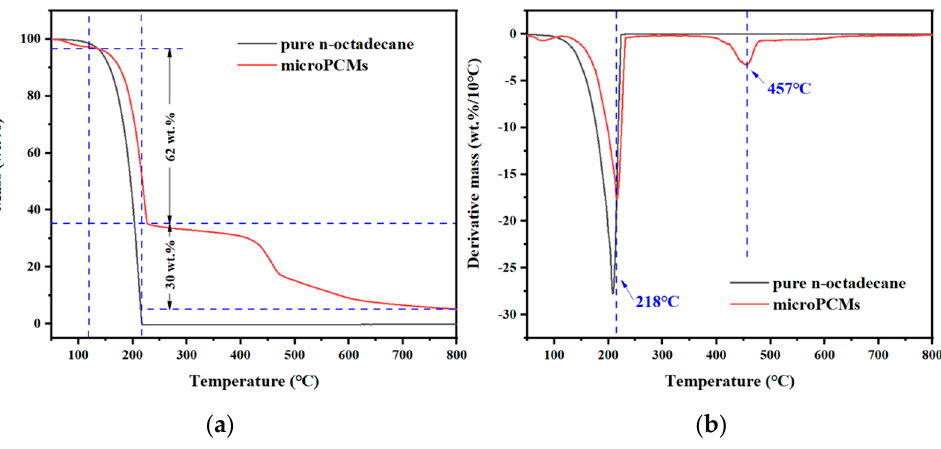
Figure 7. ( a ) TGA and ( b ) DTG data curves of n -octadecane and the microPCMs.